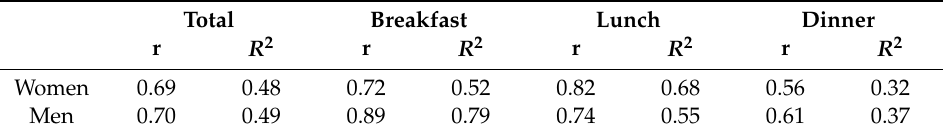
Table 2. Associations between protein (g / kg aBW) and energy (kJ / kg aBW) intake. Total Breakfast Lunch